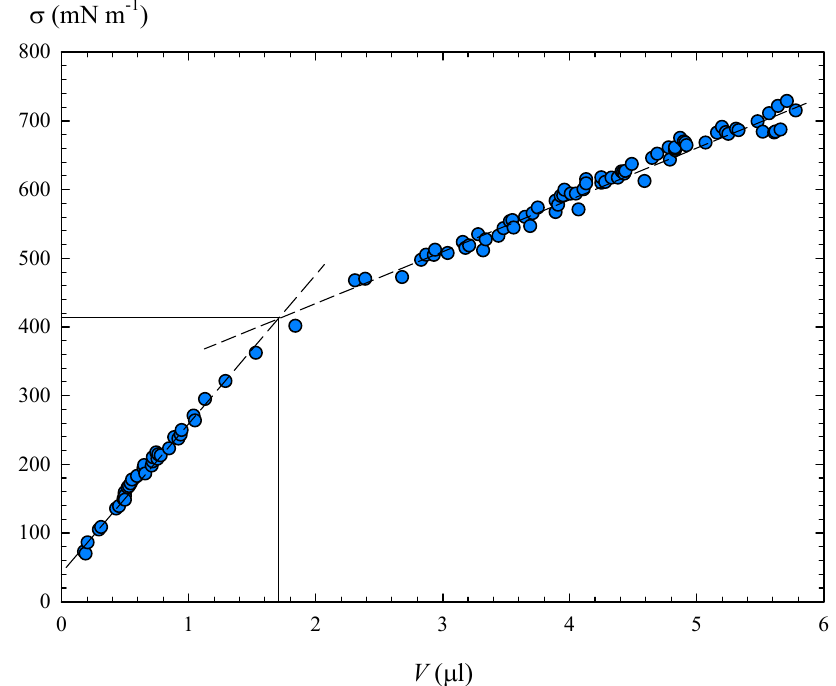
Figure 15. Apparent surface tension of Field’s metal as a function of drop